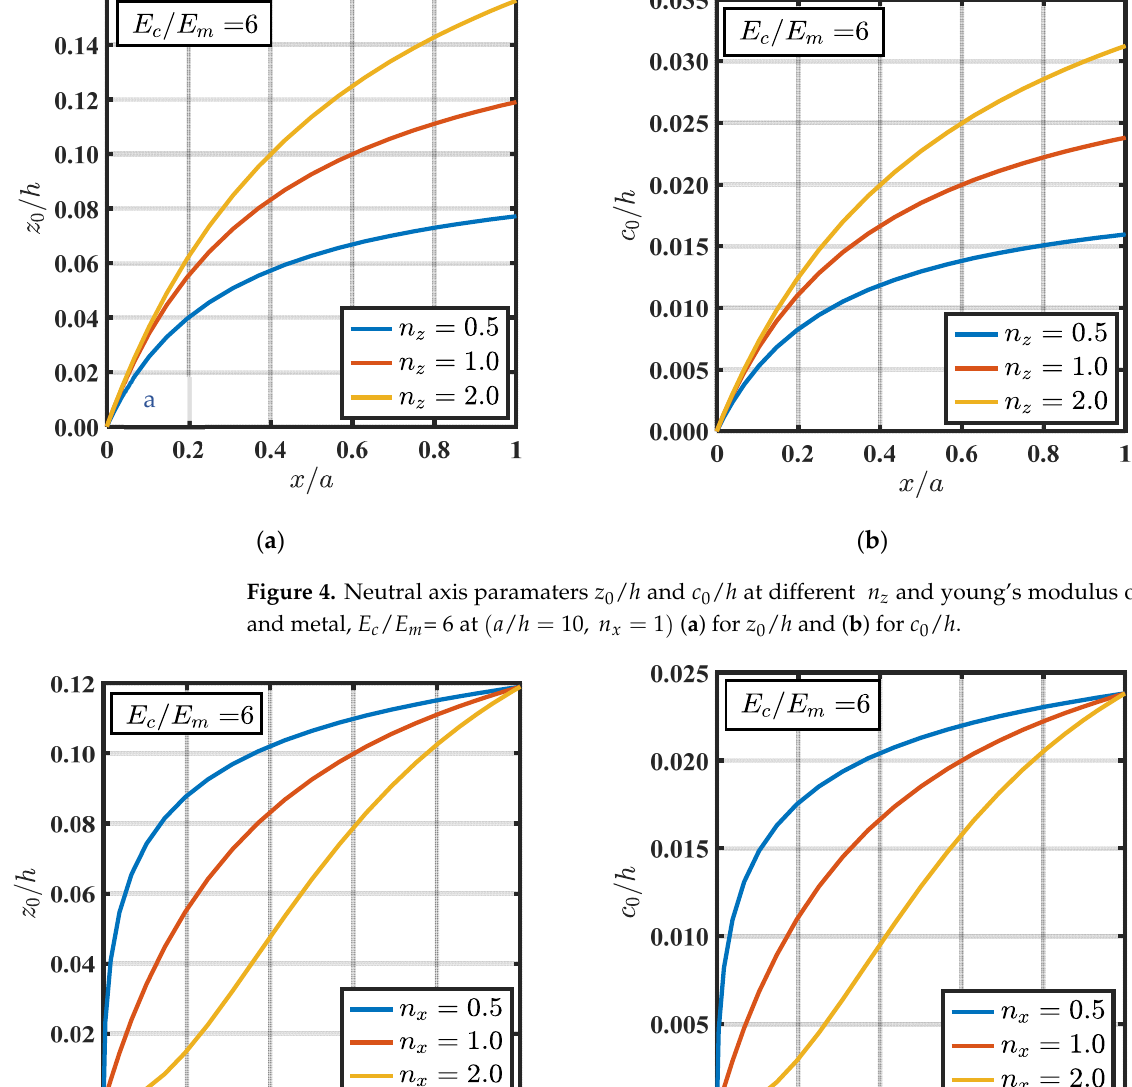
Figure 3. Maximum values of ( a ) 𝑧 (cid:2868) /ℎ and ( b ) 𝑐 (cid:2868) /ℎ at different 𝐸 (cid:3030) 𝐸 (cid:3040) ⁄